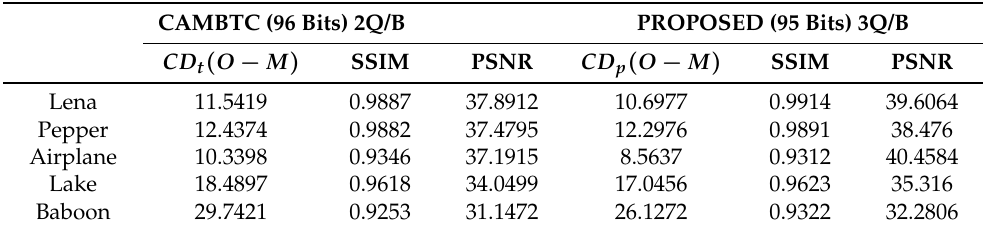
Table 1. Comparison of the quality between the tradition color AMBTC and the proposed AMBTC.